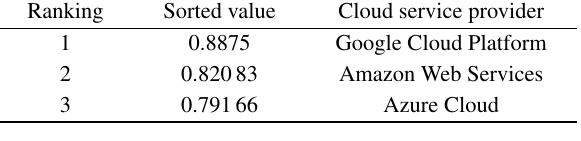
Fig. 5 Experiment 2 results. Table 15 Weighted average values and ranking in Experiment 3.